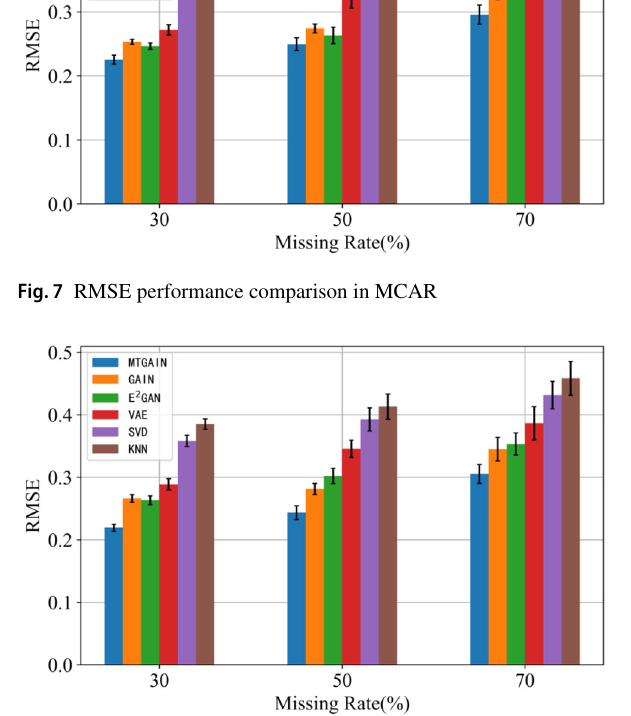
MTGAIN is compared against the same methods with respect to the accuracy of post-imputation prediction when the missing rate varies. For this purpose, AUROC is uti- lized as the measurement. Table 1 shows MTGAIN yields the best post-imputation prediction performance. In particu- lar, the advantage of MTGAIN over other models enlarges with the increase of miss rate. This is due to the fact that as the information contained in observed data